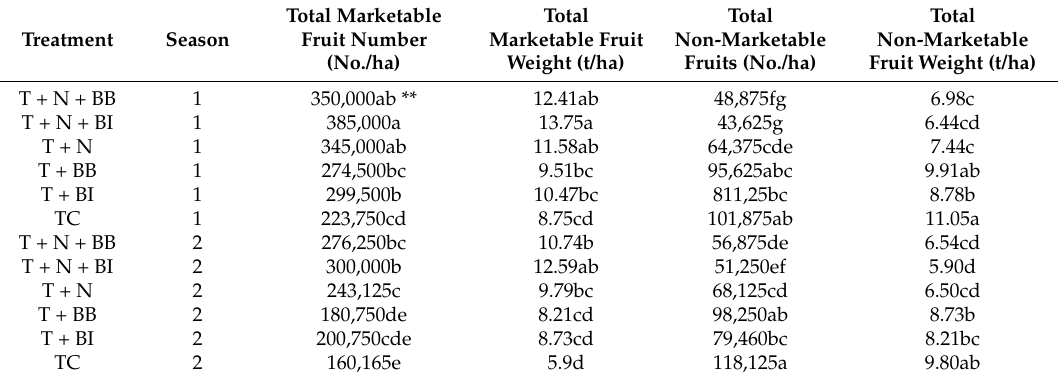
Table 1. Effects of agronet cover and companion planting basil on total marketable fruit number (No./ha), total fruit weight (t/ha), total non-marketable fruit (No./ha) and total non-marketable fruit weight during tomato production in season 1 (December 2013–April 2014) and season